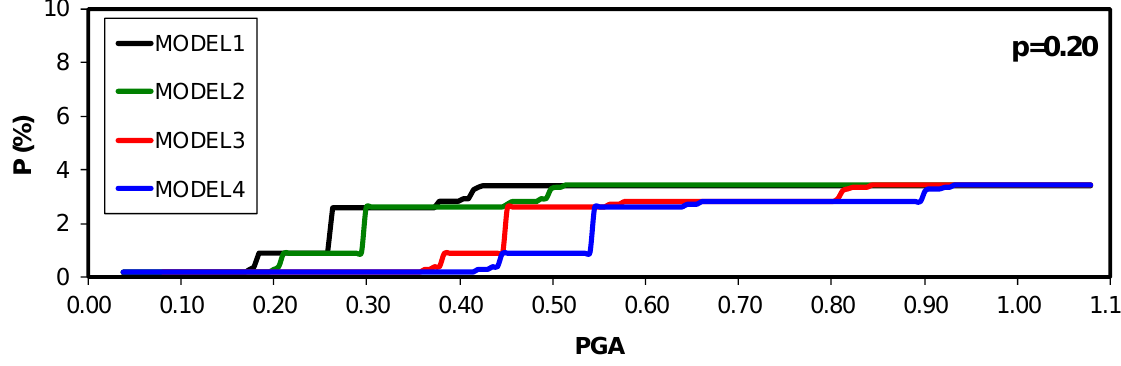
Figure 9. Indirect losses due to prolongation of time (P). Scenario 2: p 2 =0.20.